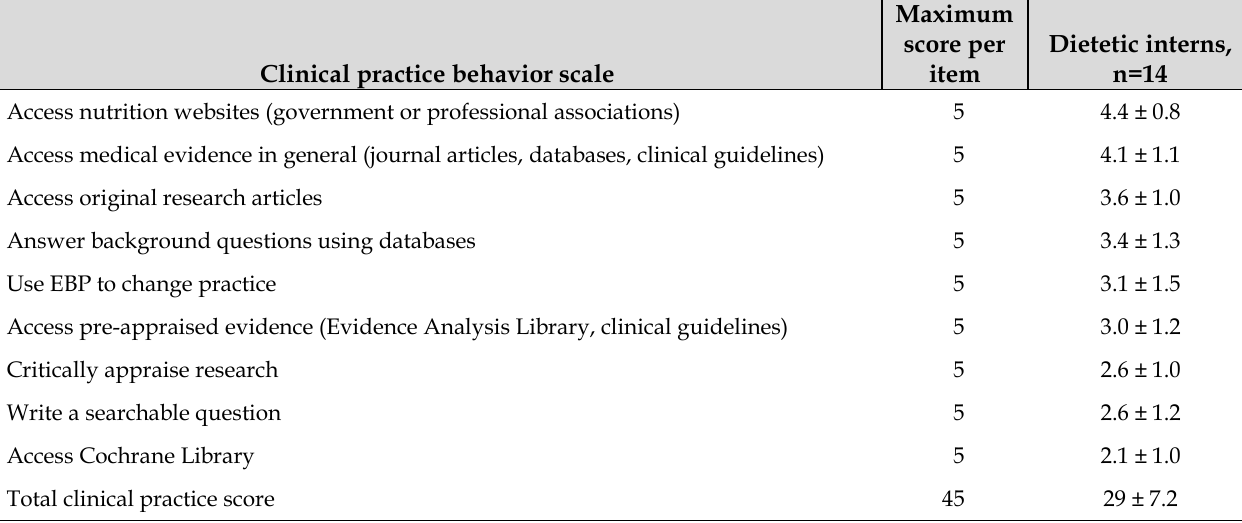
Table 2 Clinical practice behavior item and total scores (mean ± standard deviation) of dietetic interns